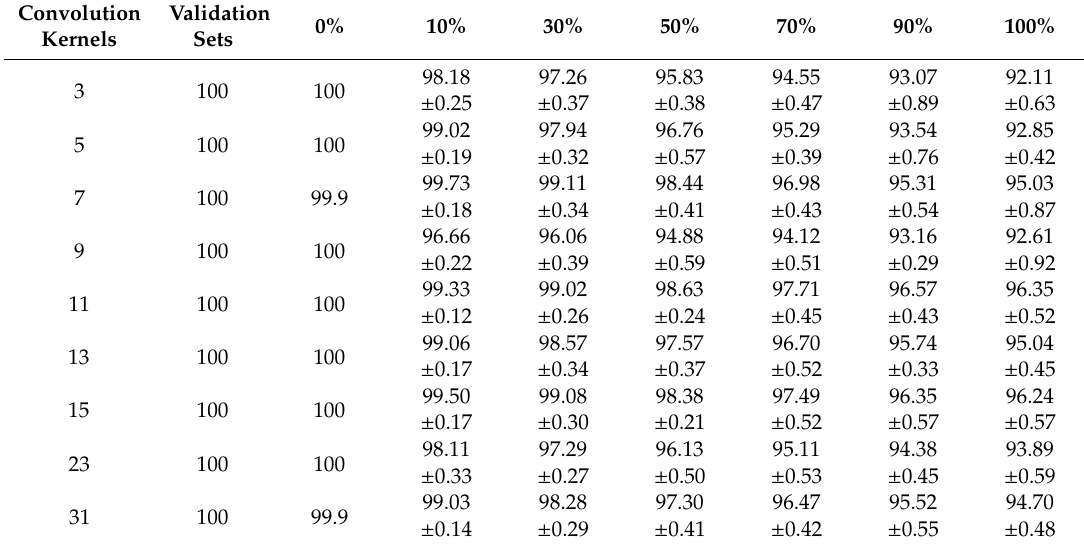
Table 7. Experimental results for the e ff ects of the size of convolution kernels in the first layer on the noise resistance of the algorithm.